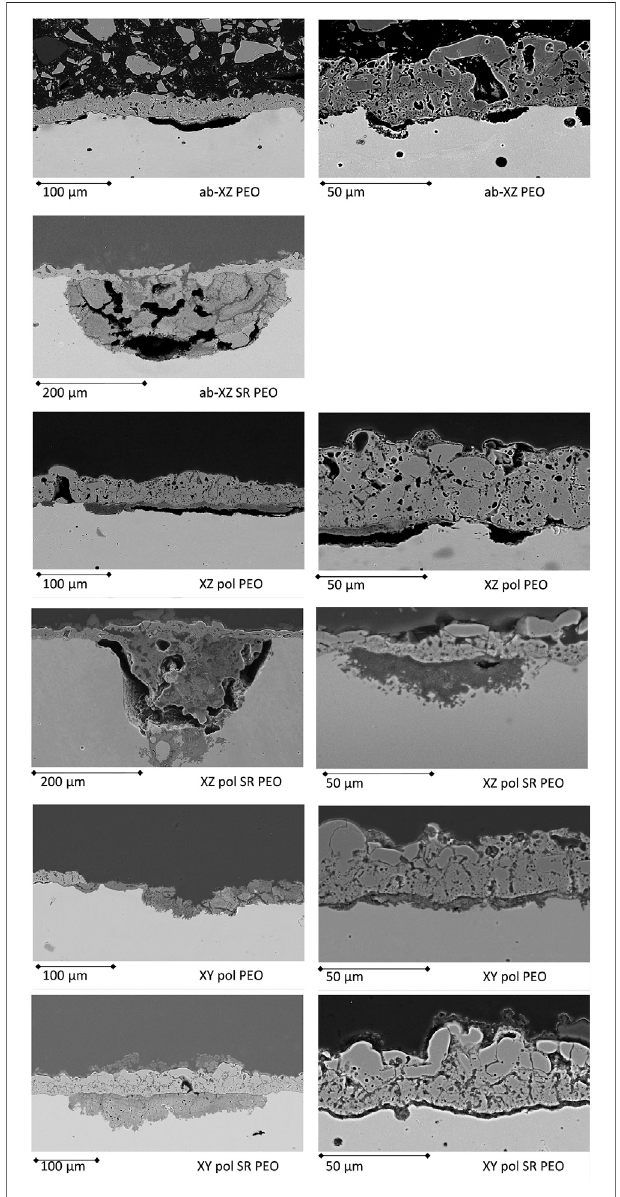
FIGURE 14 | Cross-sections of the corrosion-tested PEO AM surfaces with the most prominent corrosion events.